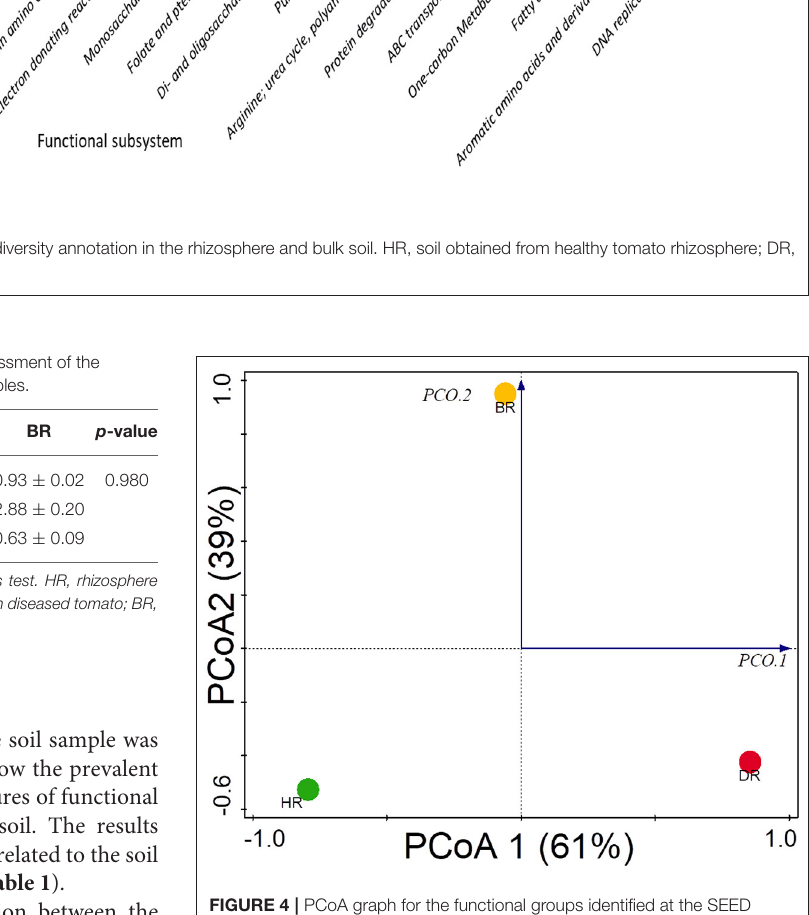
Healthy tomato rhizosphere soil possessed some predominant functional categories ( Supplementary Table S2 , Figure 1 ).